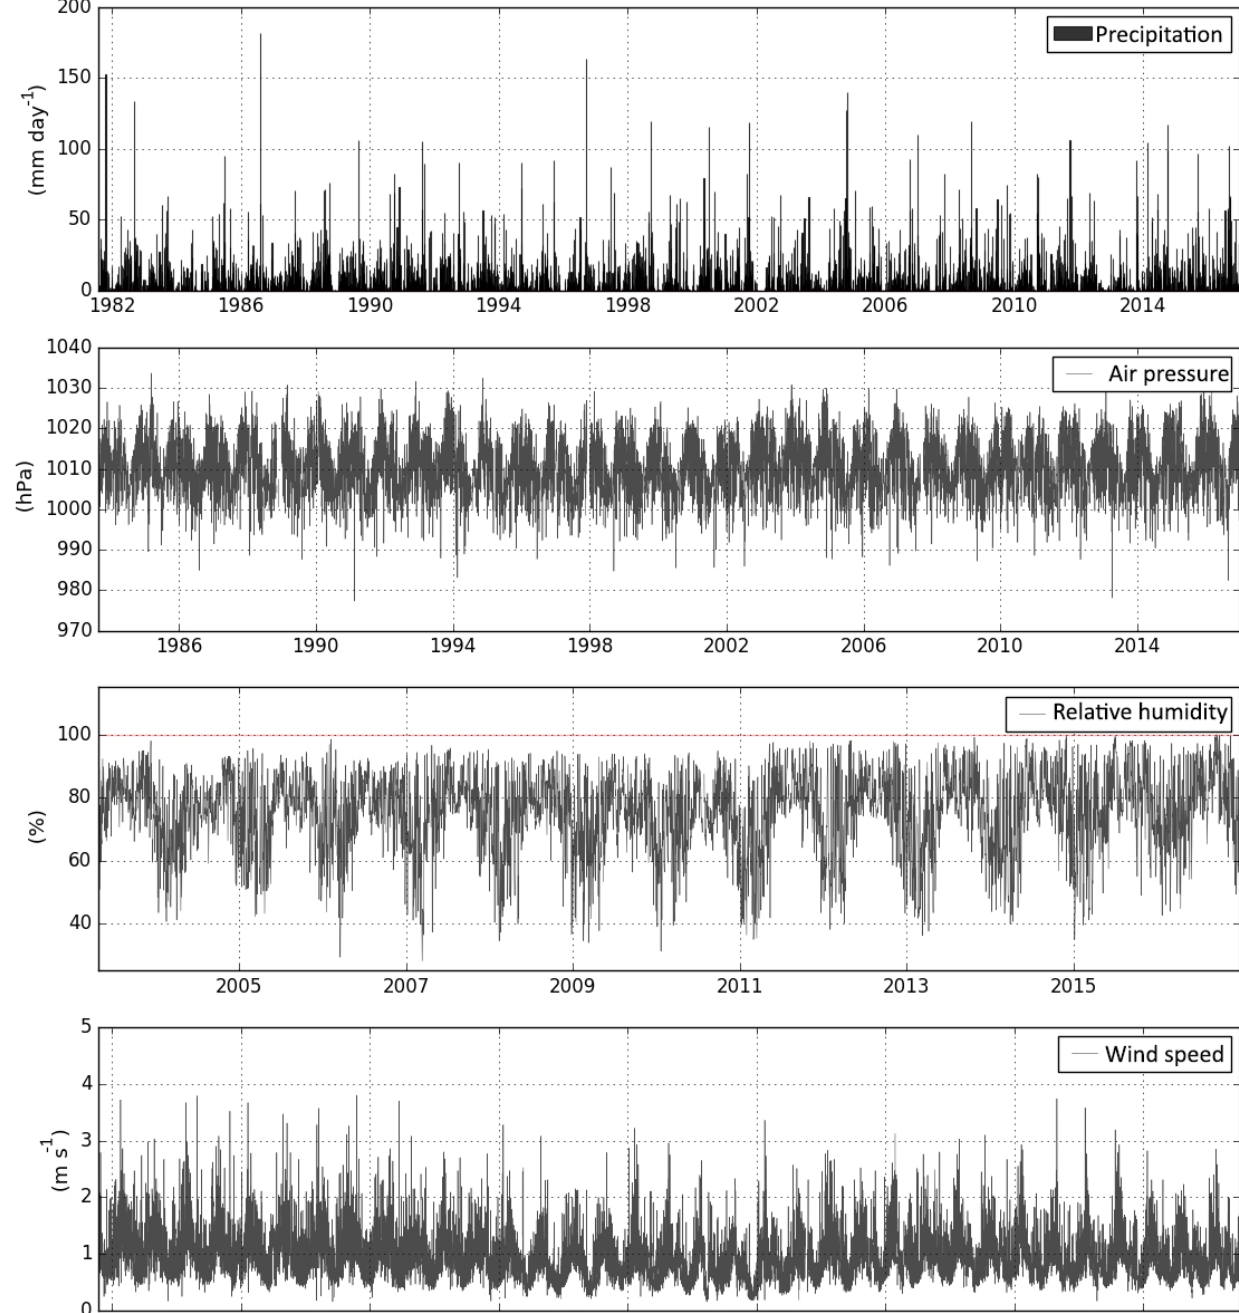
imum values of the air temperature all show a positive trend with an increase of 0.04 ◦ C year − 1 . Here, the minimum value increased more slowly than the other two statistics, because the minimum air temperature is highly affected by urbaniza- tion (Kondo et al., 1994), where the main construction pe- riod of Tsukuba occurred within the 1980s and slowed down